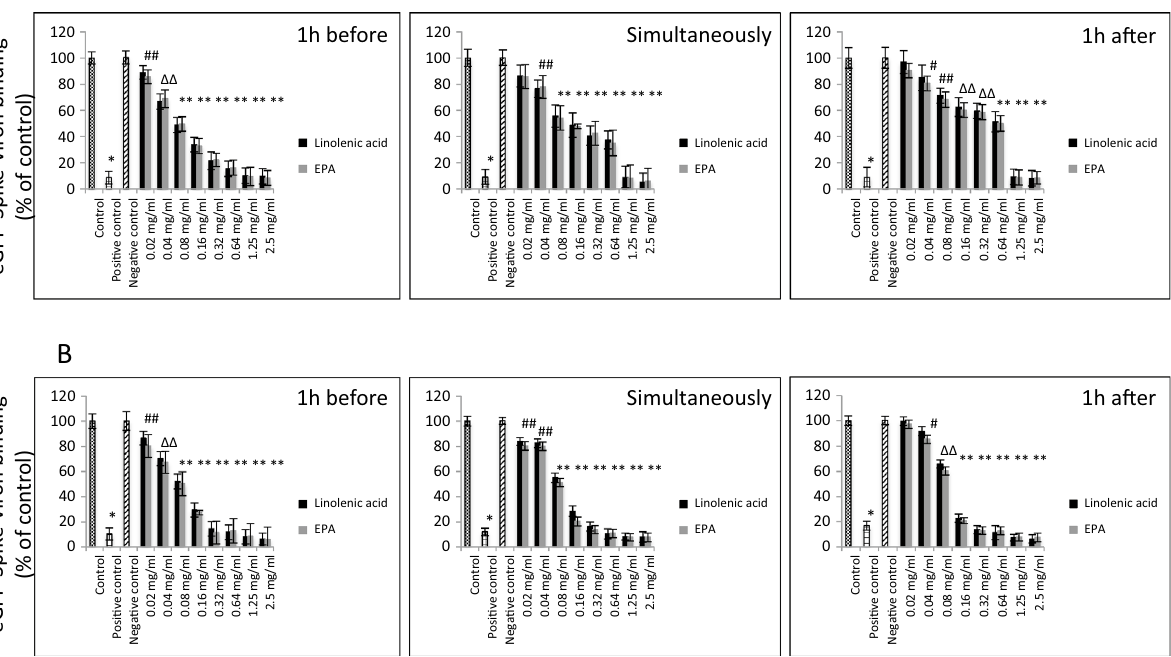
Figure 3. Effects of linolenic acid and EPA on SARS-CoV-2 pseudo-virion binding to human ACE2 receptor. Binding SARS-CoV-2 spike protein encapsulated pseudo-virions to A549 cells stably overexpressing human ACE2 receptor was evaluated with monoclonal antibody. ( A ) Spike-pseudo-virions were treated with indicated FAs at different concentrations for 1 h before inoculation, added simultaneously or 1 h after inoculation of the virions into hACE2/A549 cells. Next, wells were incubated for 1 h at 37 O C, washed and binding was evaluated by adding primary anti-spike protein monoclonal antibody at 1:1000 dilution followed by secondary HRP- conjugated antibody at 1:2500 dilution and signal measurement at 450 nm. ( B ) Spike-pseudo-virions were treated with indicated FAs at different concentrations for 1 h before inoculation, added simultaneously or 1 h after inoculation of the virions into hACE2/A549 cells. Next, wells were incubated for 3 h at 37 O C, washed and binding was evaluated by adding primary anti-spike protein monoclonal antibody at 1:1000 dilution followed by secondary HRP-conjugated antibody at 1:2500 dilution and signal measurement at 450 nm. Data are presented as % of control ± SD; # p ≤ 0.05, ∆ p ≤ 0.01, * p ≤ 0.001. Controls—0.025% DMSO, positive and negative controls were provided by the